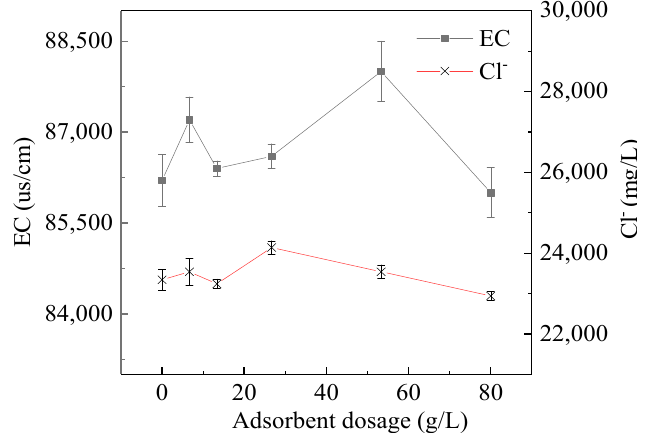
Figure 1 . Absorption and removal rate with the adsorbent dosage changes.